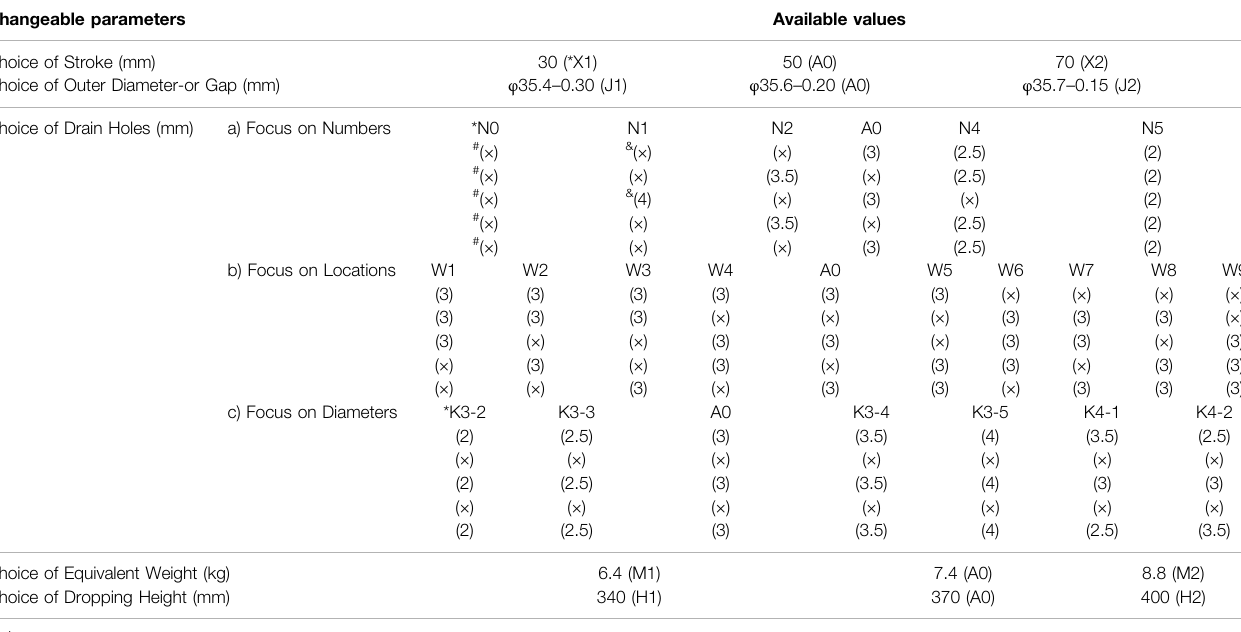
TABLE 2 | Settings for Changeable Structures in series of Univariate Experiments.